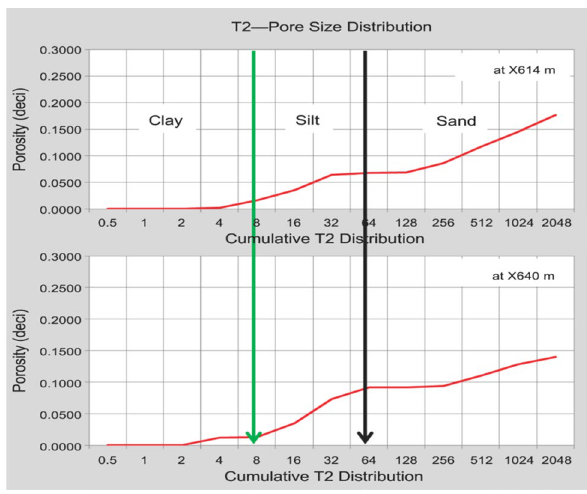
Fig. 5 NMR cumulative T